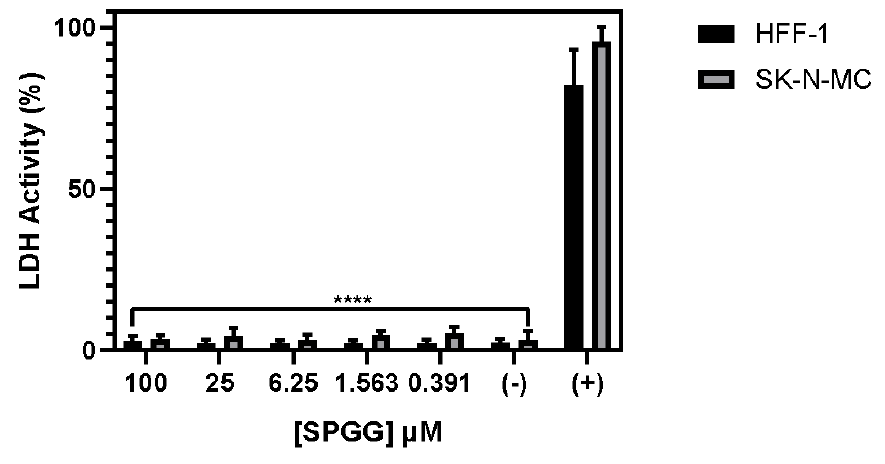
Figure 2. E ff ect of SPGG on HFF-1 and SK-N-MC cells. The cells monolayers were incubated in the presence or absence of SPGG in a dose dependent manner. Controls; ( + ) represents maximum lactate dehydrogenase (LDH) activity control, ( − ) represents the spontaneous LDH release control. A one-way analysis of variance (ANOVA) determined significant di ff erence among means with a P -value of < 0.0001 in both cell types. Dunnett’s multiple comparison test found significant di ff erences between the mean of each treatment in comparison to the mean of the positive control column, (****) signifies a P -value of < 0.0001. The graph is indicative of the mean values and SD of triplicate experiment.